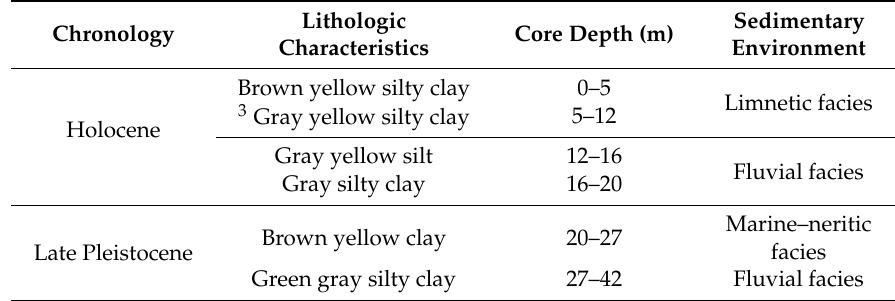
Table 3. Geological conditions for Suzhou.